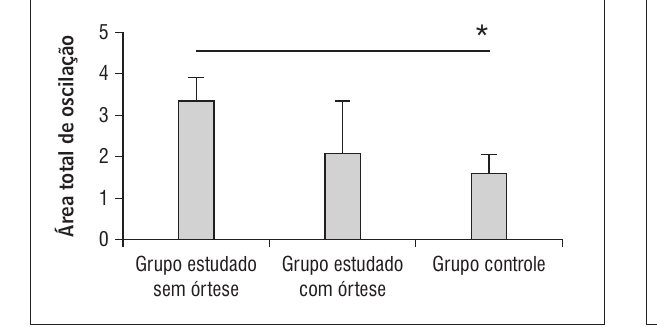
Figura 1 - Variação da área total de oscilação do COP do GE (com e sem órtese) e GC Fisioter Mov. 2012